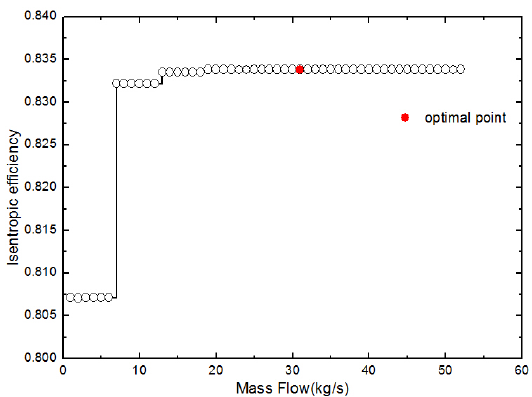
Figure 6. Optimization